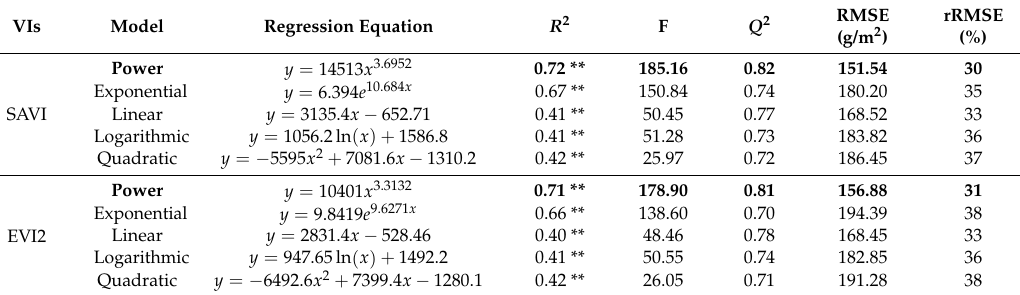
Remote Sens. 2017 , 9 , 238